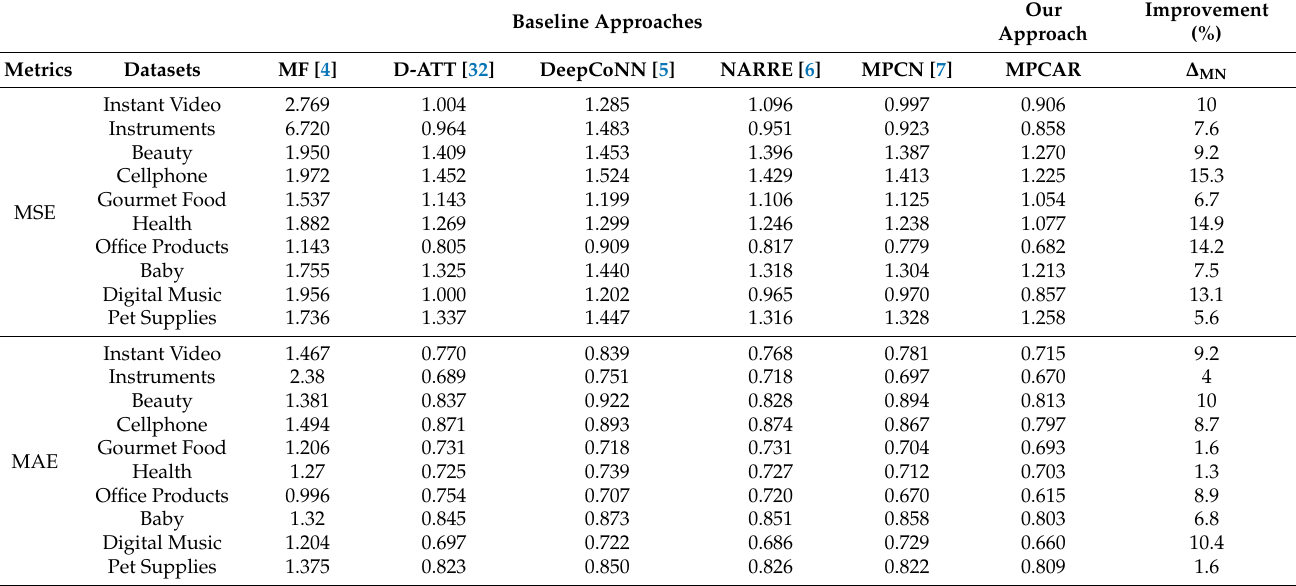
Table 4. Performance comparison (MSE and MAE) on 10 amazon subdatasets. ∆ MN is the relative improvement of MPCAR over MPCN